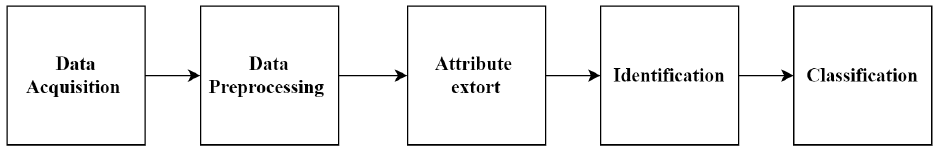
Figure 1. Traditional image pre-processing techniques: The basic method of identifying plant diseases using conventional image recognition processing